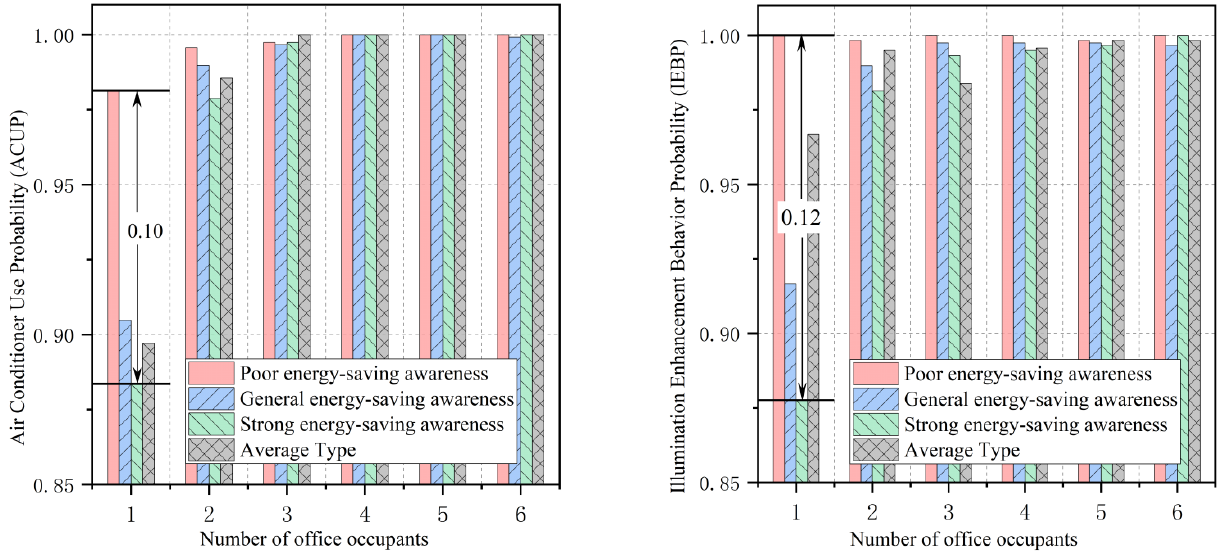
Figure 18. The average ACUP and IEBP during a typical period of time in an office with different occupancy levels and awareness of energy saving.